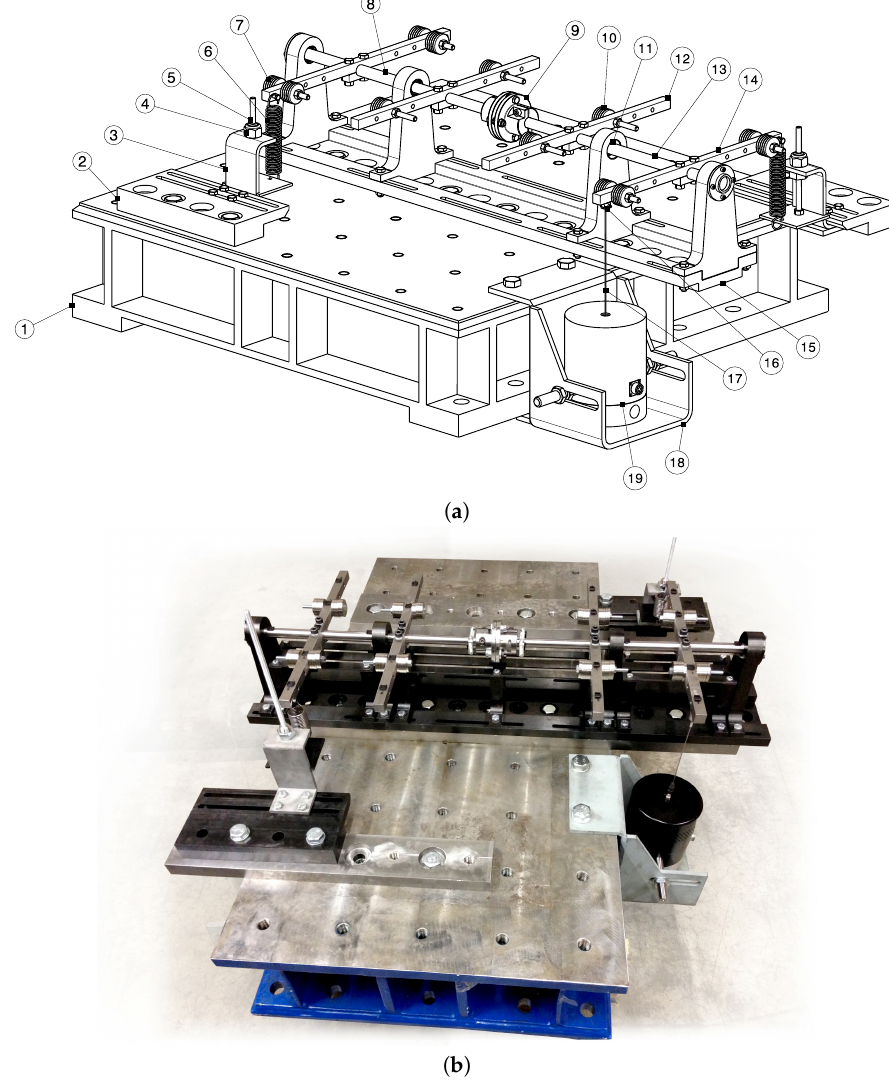
Figure 3. ( a ) Technical drawing & ( b ) picture of the novel test